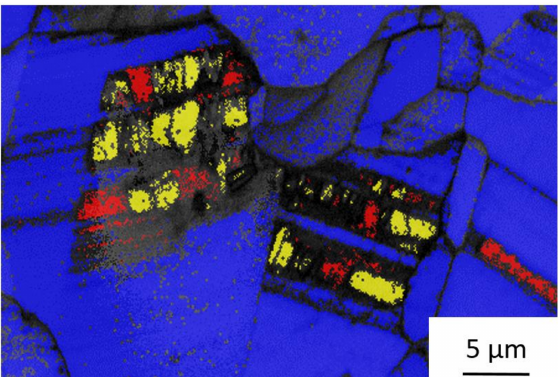
Figure 3. Electron backscatter diffraction (EBSD) analysis—identification of phases in annealed sheet T15-81: ( α (cid:48) -martensite—yellow, ε -martensite—red; γ -austenite—blue).